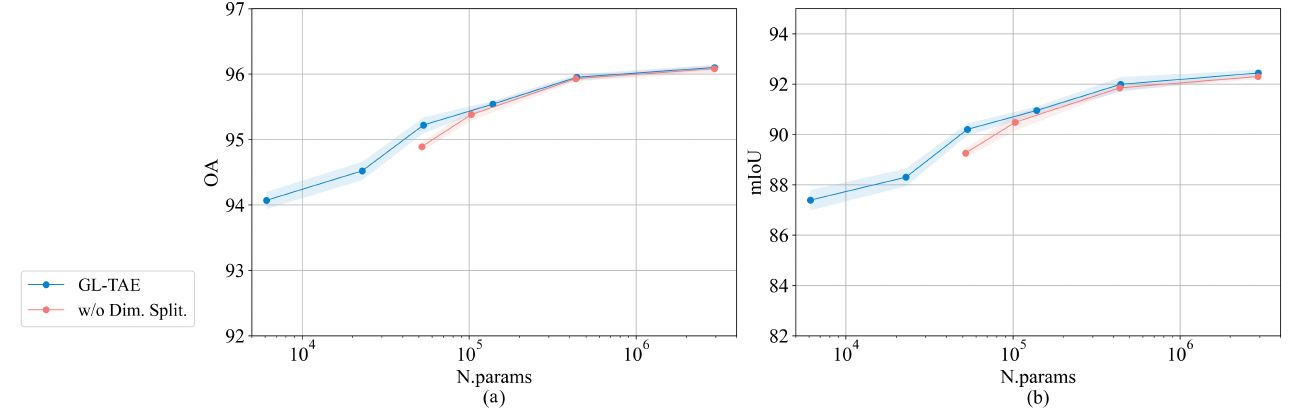
Figure 9. Performance of ( a ) OA and ( b ) mIoU on the TimeSen2Crop of GL-TAE with/without Dim. Split ; plotted with respect to the parameter